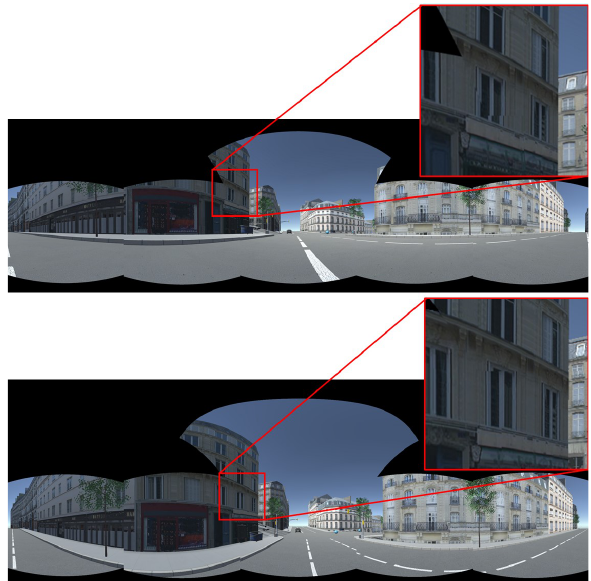
Figure 10. Panorama from camera rig with stereo base length of 60 cm and projected sphere radius of 20 m (top) and 80 cm and projected sphere radius of 20 m